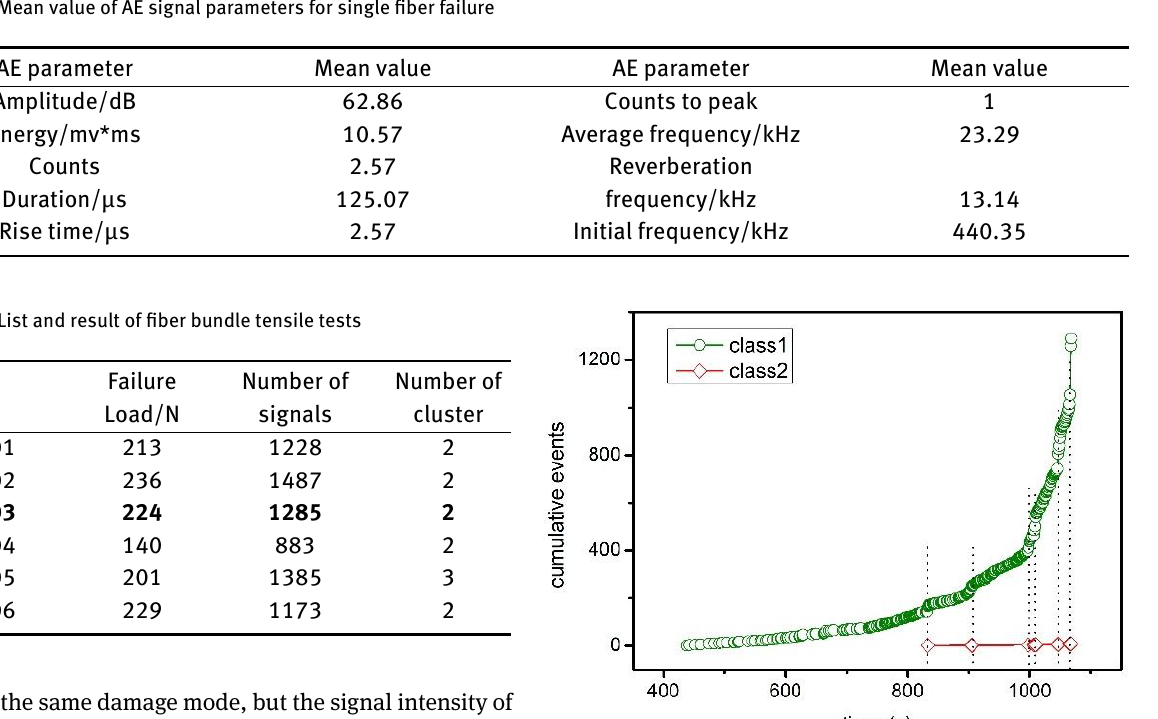
Table 3: Mean value of AE signal parameters for single fiber failure